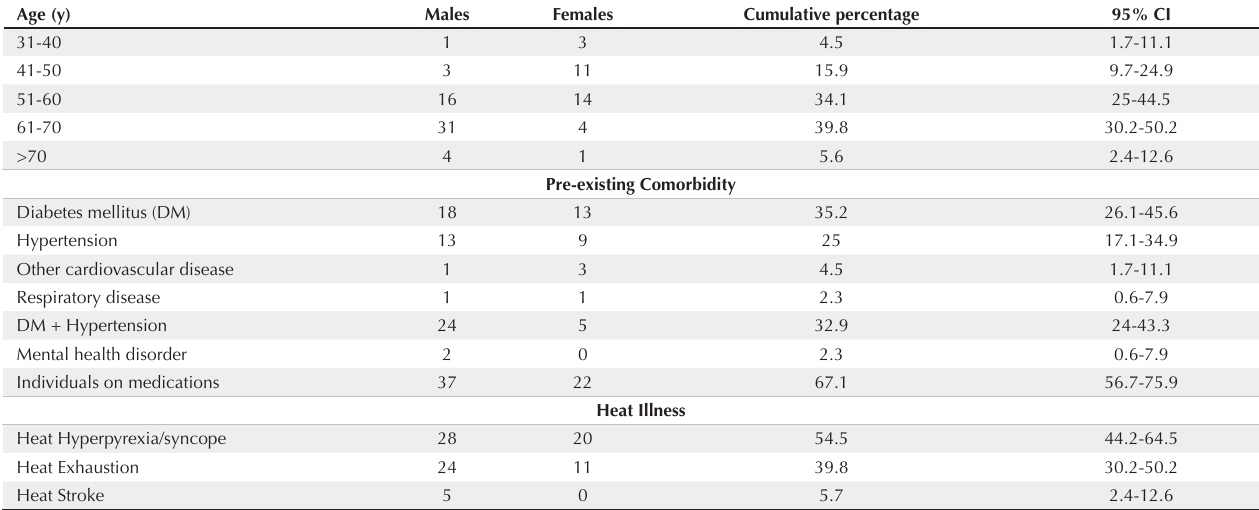
Table 1. Age, Gender, Comorbidity Profile, and Lead Diagnosis of Patients With Heat Illnesses During Hajj, 2016 Age (y) Males